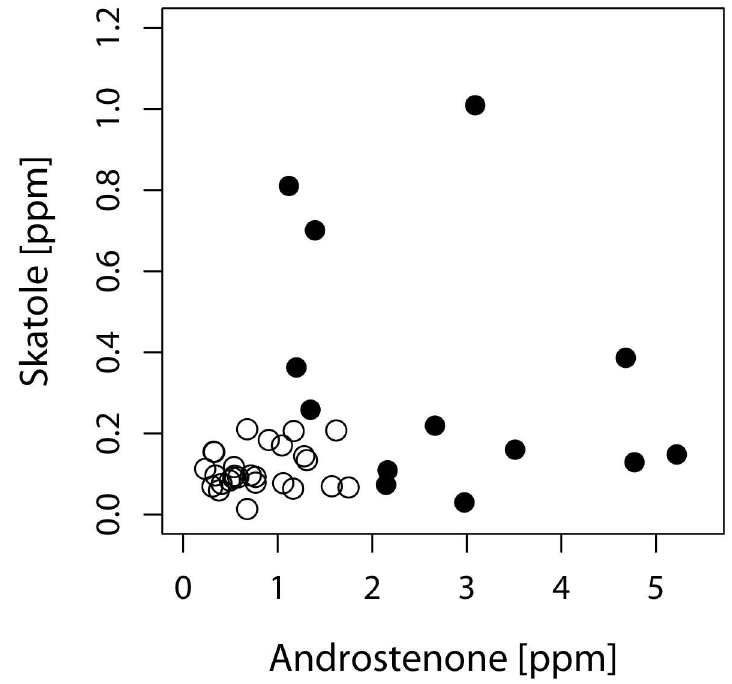
Fig 1. Contents of androstenone and skatole in biological samples of fat tissue of boars used for the quality control task. Boar taint compoundswere determined in melted back fat using gas chromatography mass spectrometry. Different symbols indicate whetheror not samples are considered to be truly boar tainted ( ● ) or untainted( (cid:14) ) based on chemicalanalysisas per the definitionof CHEMHIGH